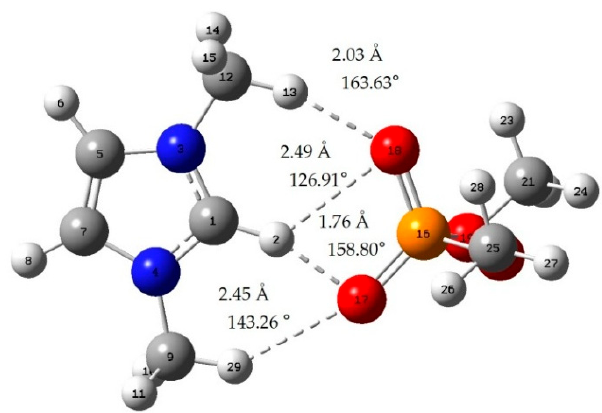
Figure A2 . [MMIM][DMP]; red: oxygen atom; green: chlorine atom gray: carbon atom; white: hydrogen atom; blue: nitrogen atom; dotted line: hydrogen bond.